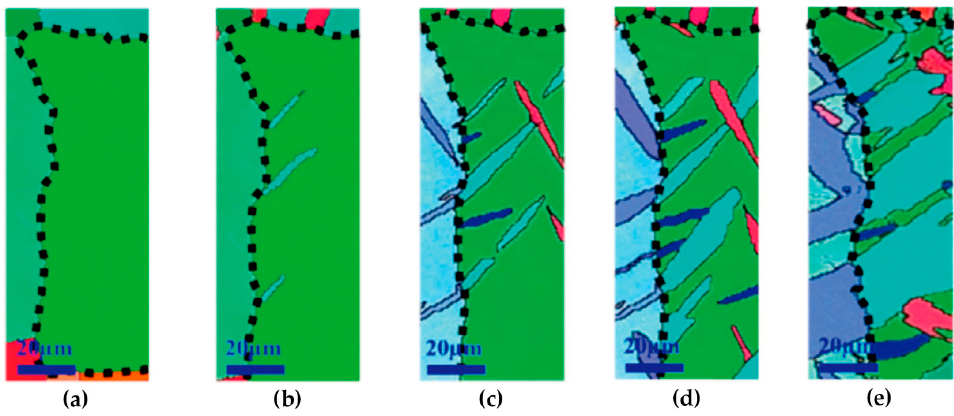
Figure 28. The twin–twin interaction in Mg at true strains of ( a ) 0%, ( b ) 1.2%, ( c ) 2.5%, ( d ) 5.5% and ( e ) 8%, respectively. (Reprinted from Reference [155], with permission from Elsevier).